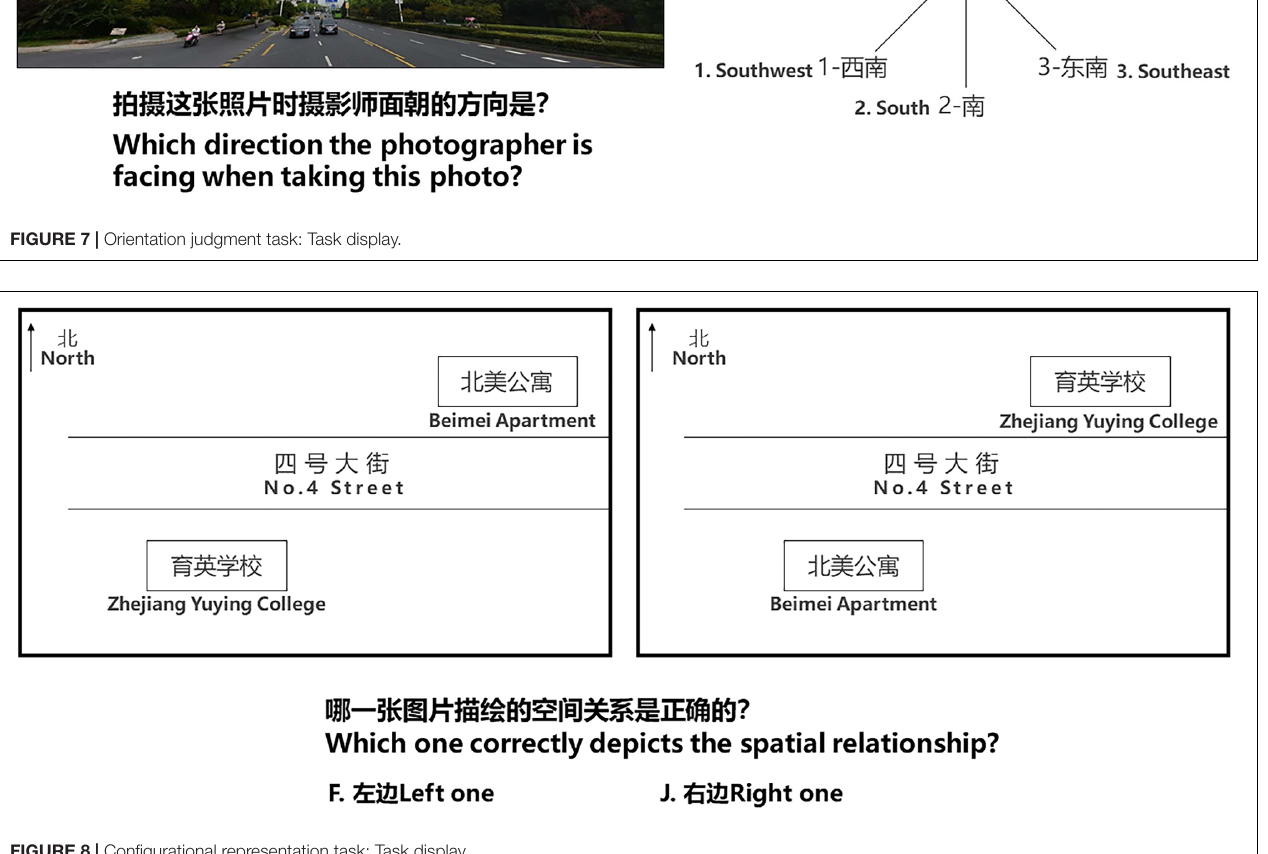
( Figure 4 ) relative to the learning area within the